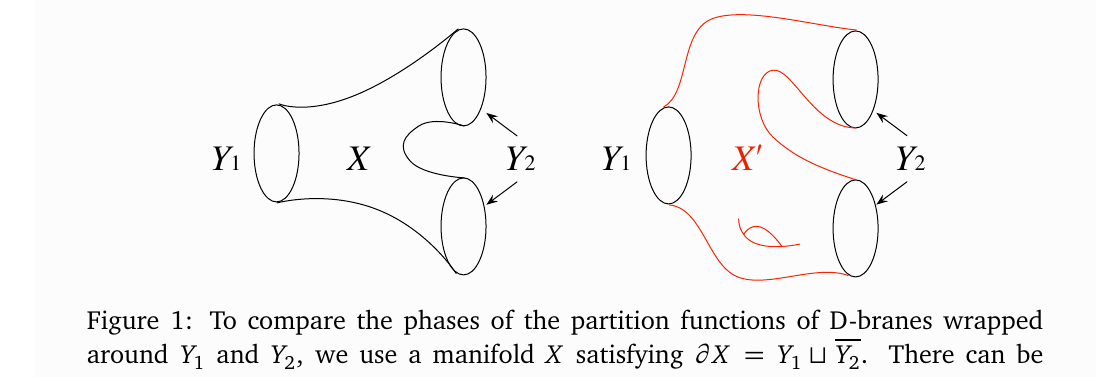
Figure 1: To compare the phases of the partition functions of D-branes wrapped around Y and Y , we use a manifold X satisfying ∂ X = Y 1 2 multiple such